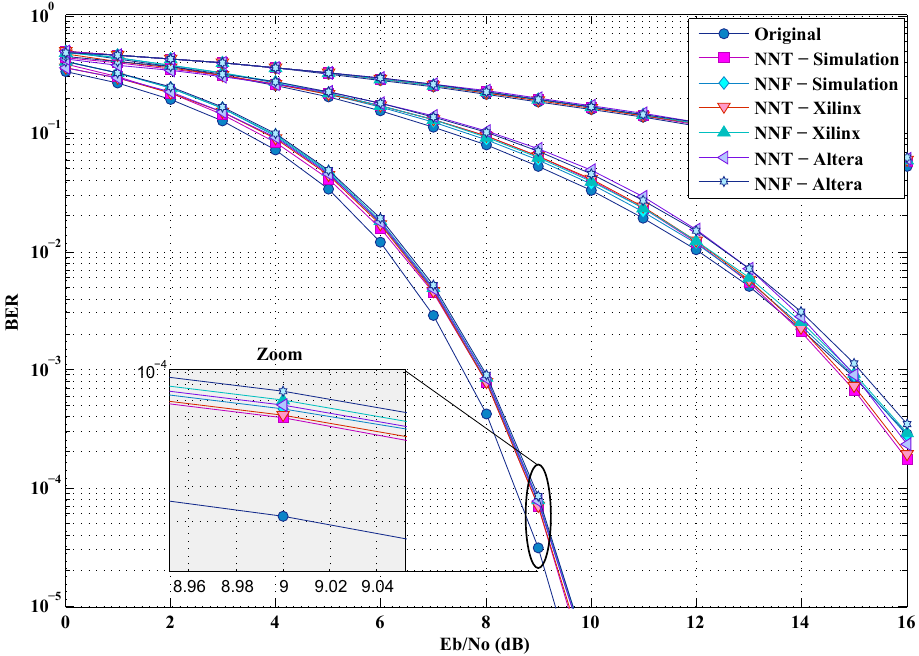
Figure 19. BER of the implementations for a CM4 channel.